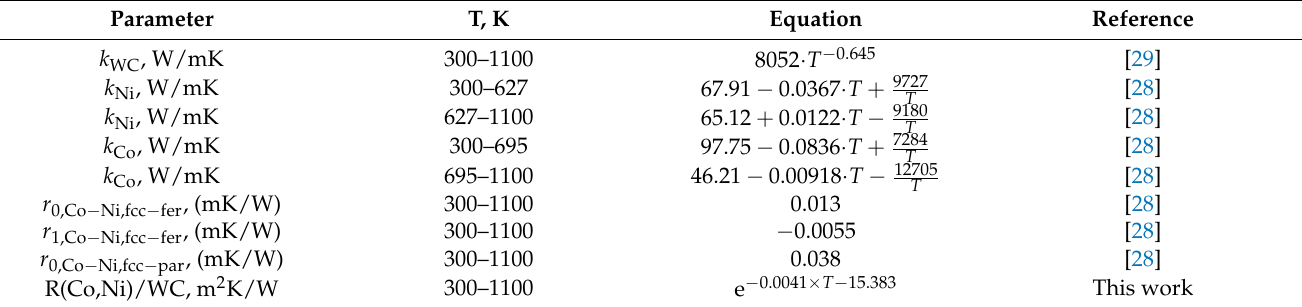
Table 2. The evaluated parameters in Equations (6) and